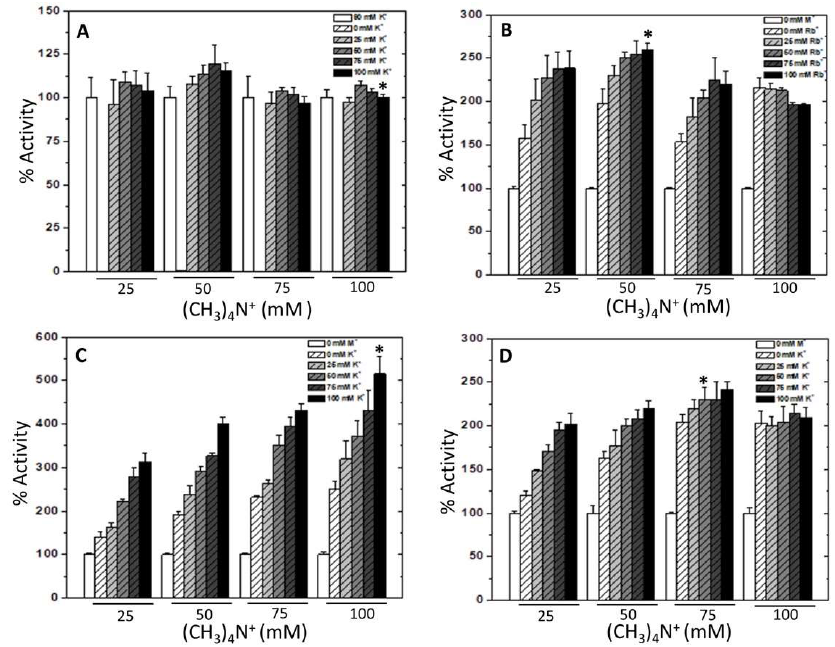
Figure 3. Effect of the addition of various concentrations of K + (or Rb + ) and (CH 3 ) 4 N + on the activities of WT-RMPK ( A ), E117K ( B ), T113L/E117K ( C ) and T113L/K114Q/E117K ( D ) mutants. Ionic strength and activities with 90 mM K + ( A ) and without monovalent cations ( B – D ) were those indicated in the legend of Figure 2. The normalized control activities were shown in white columns in ( A – D ). White striped columns were in the presence of 25, 50, 75, and 100 mM (CH 3 ) 4 N + concentrations without K + (or Rb + ). In addition to the indicated (CH 3 ) 4 N + concentration, light gray, gray, dark gray, and black striped columns were in the presence of the 25, 50, 75, and 100 mM K + (or Rb + ) concentrations, re- spectively. The highest activities of RMPK mutants were achieved with ionic strength of 250 mM pointed out with *. Standard deviation bars of three experiments are shown. In previous studies of the E117K mutant [15,20], this effect was not observed because both used (CH 3 ) 4 N + to maintain ionic strength constant. Still, they did not explore the effect of increasing ionic strength on the activity of this mutant. Following the phylogenetic analysis [16], K + binds to a highly conserved site. In the K + -independent PKs, three of the four residues that coordinate K + are conserved in most enzymes. The only residue missing is T113 (numbering according to RMPK) which is Leu in K + -independent PKs. Hence, it is not surprising that these PKs still bind a monovalent cation as observed in the structure of Mtb PK [18]. 2.2. Effect of Activating Monovalent Cations to WT-RMPK and RMPK Mutants in the Presence of 250 mM Ionic Strength Maintained with (CH 3 ) 4 N + . The activation of WT-RMPK, K114Q, E117K, T113L/E117K and T113L/K114Q/E117K mutants by different concentrations of Li + , Na + , K + , NH 4+ , Rb + and Cs + were measured and compared in the presence of saturating concentrations of PEP 3− , Mg-ADP complex and Mg 2+free and constant ionic strength of 250 mM (Figure 4). In confirmation of previous re- sults [3], it was observed that maximal WT-RMPK activation followed the order K + > NH 4+ > Rb + > Cs + > Na + > Li + . It is important to note that the activation curves of WT-RMPK with Na + and Li + did saturate (see Table 1). In previous studies, WT-RMPK activation exhibited no saturation of these cations at an ionic strength of 223 mM ionic strength maintained with HEPES [21]. (CH 3 ) 4 N + may bind to non-specific sites of the enzyme favoring Na + and Li + occupation of the monovalent binding site. As expected K114Q mutant was K + -de- pendent. Ion selectivity was preserved and kinetic constants for the monovalent cations